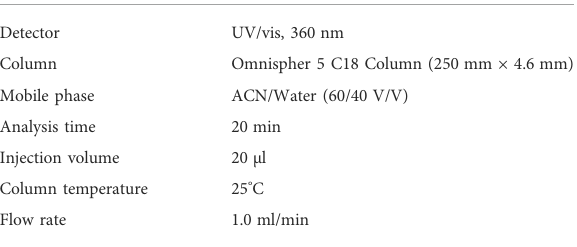
TABLE 4 High-performance liquid chromatography (HPLC) HCHO analysis conditions. HCHO analysis